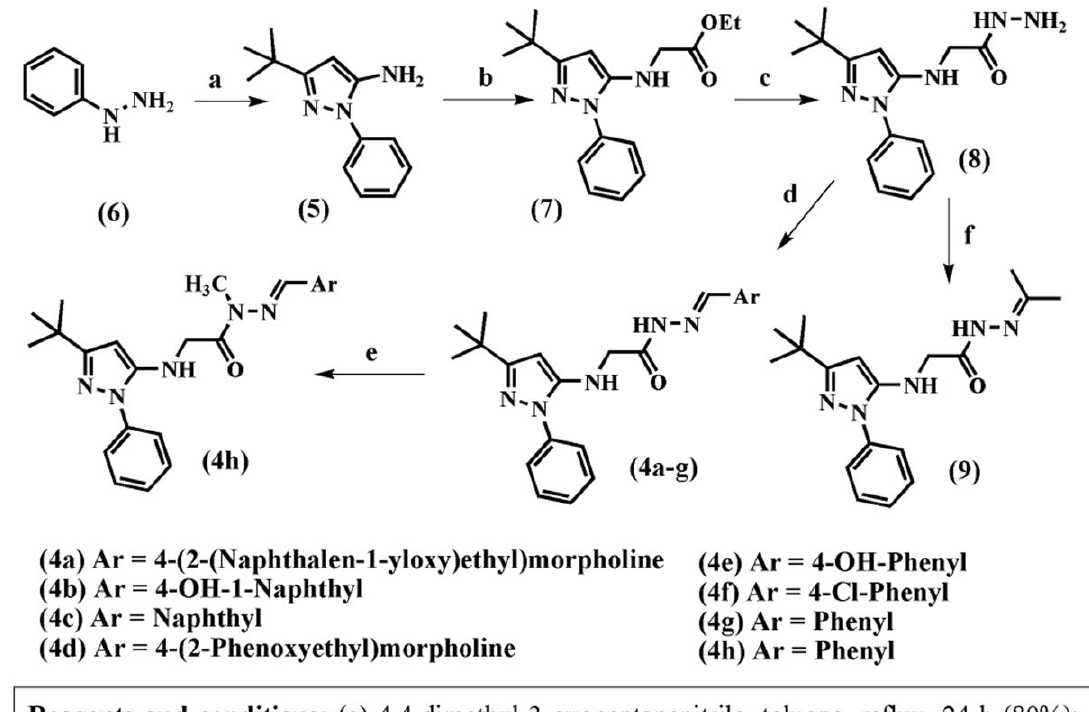
Figure 3. Synthesis of N -phenylpyrazolyl- N -glycinyl-hydrazone derivatives 4a–h.